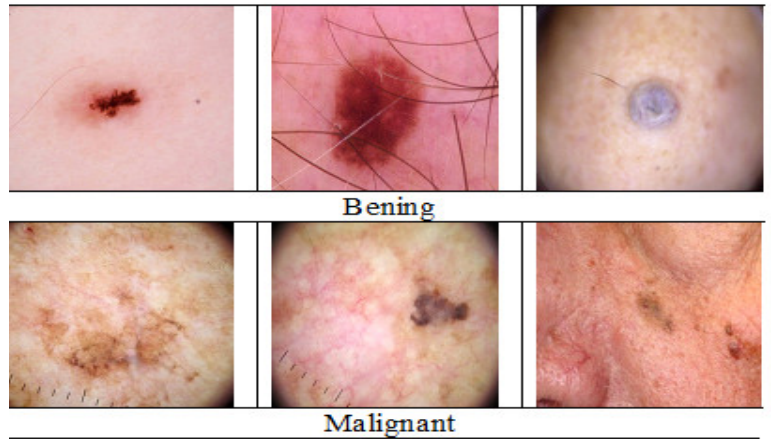
Figure 3. Samples for benign and malignant cancer in the